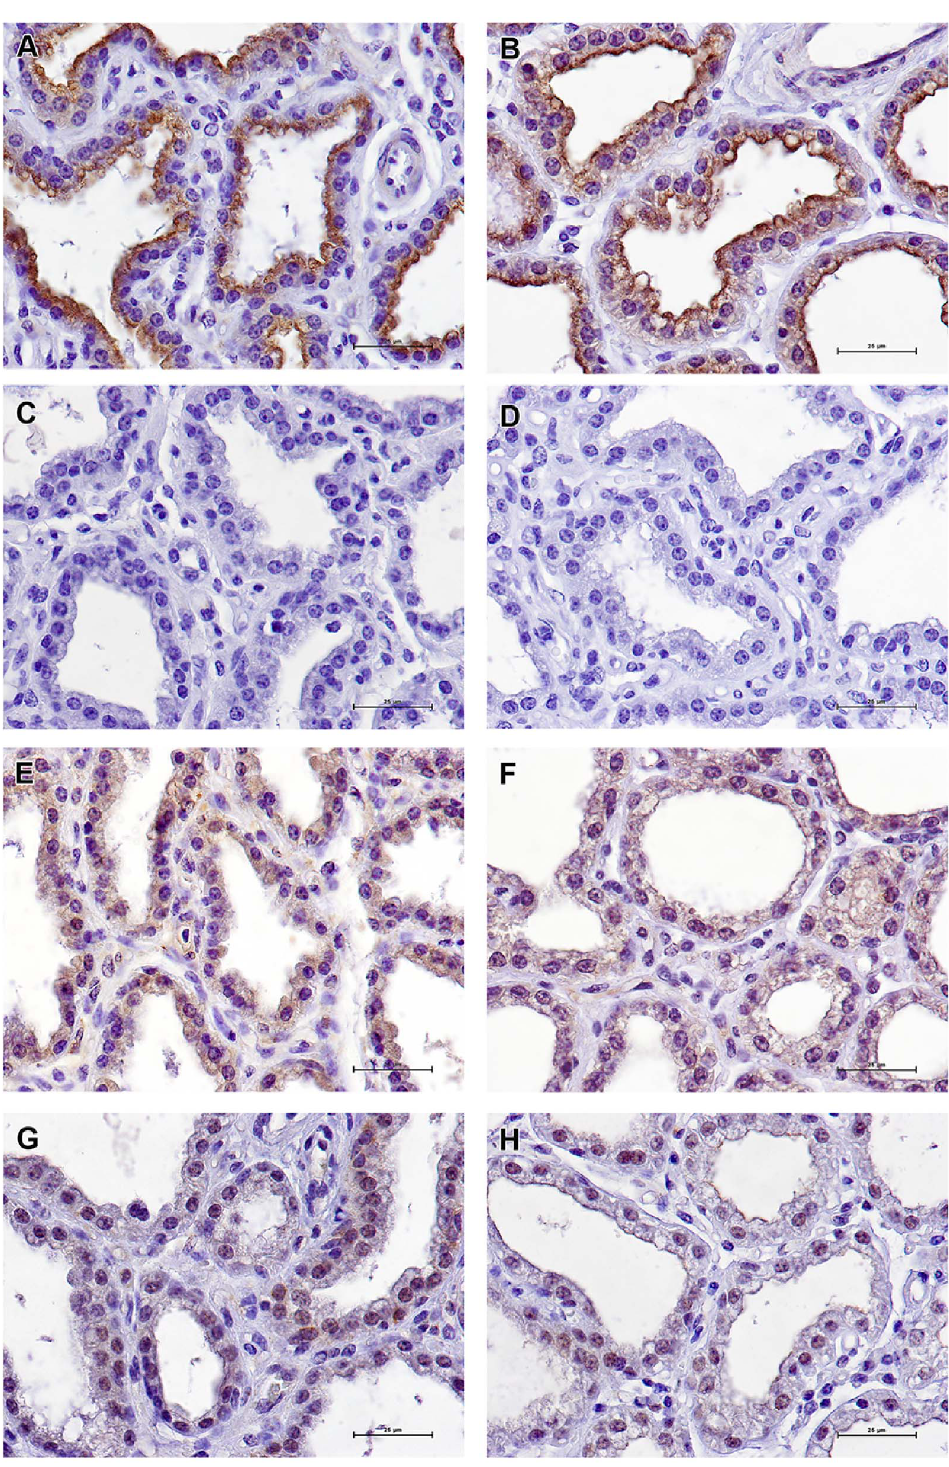
Figure 9. Analysis by immunohistochemistry of representative tissue sections of uninfused, healthy mammary glands. A–B) Immunoreactivity of the apical side of the epithelial cells lining the alveoli to the N-term antibody to IL-17A of cows # 1018 and 2014, respectively; C) Inhibition of labeling by Ab to N-terminal IL-17A peptide with the peptide antigen (cow # 1018); D) Negative control with Ab to ovalbumin and second antibody conjugated to horseradish peroxidase (cow # 1018); E–F) Immunoreactivity of the epithelial lining the alveoli to abcam antibody (cows # 1018 and 2014, respectively); G–H) Immunoreactivity of mammary tissue of healthy uninfused quarters of cows 1018 and 2014 to the C-term antibody, respectively. Scale bars indicate 25 m m.